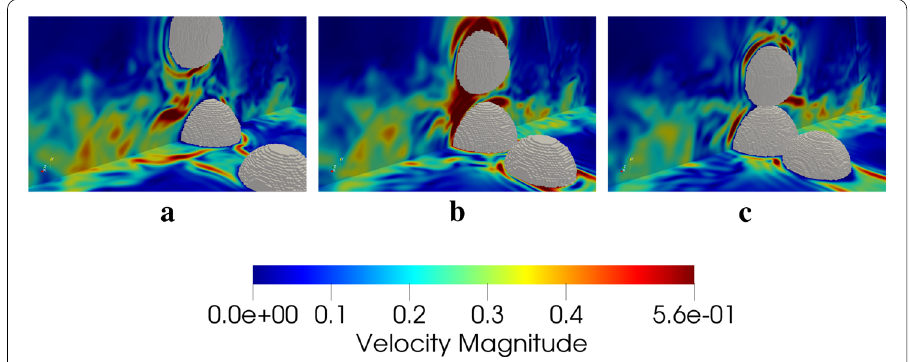
Fig. 16 Collision of three spheres at different simulation time, when a the spheres are at their respective maximum position after 9 . 5 s . In b spheres move towards each other after 9 . 8 s and c spheres get in contact with each other at their respective interfaces after 10 s